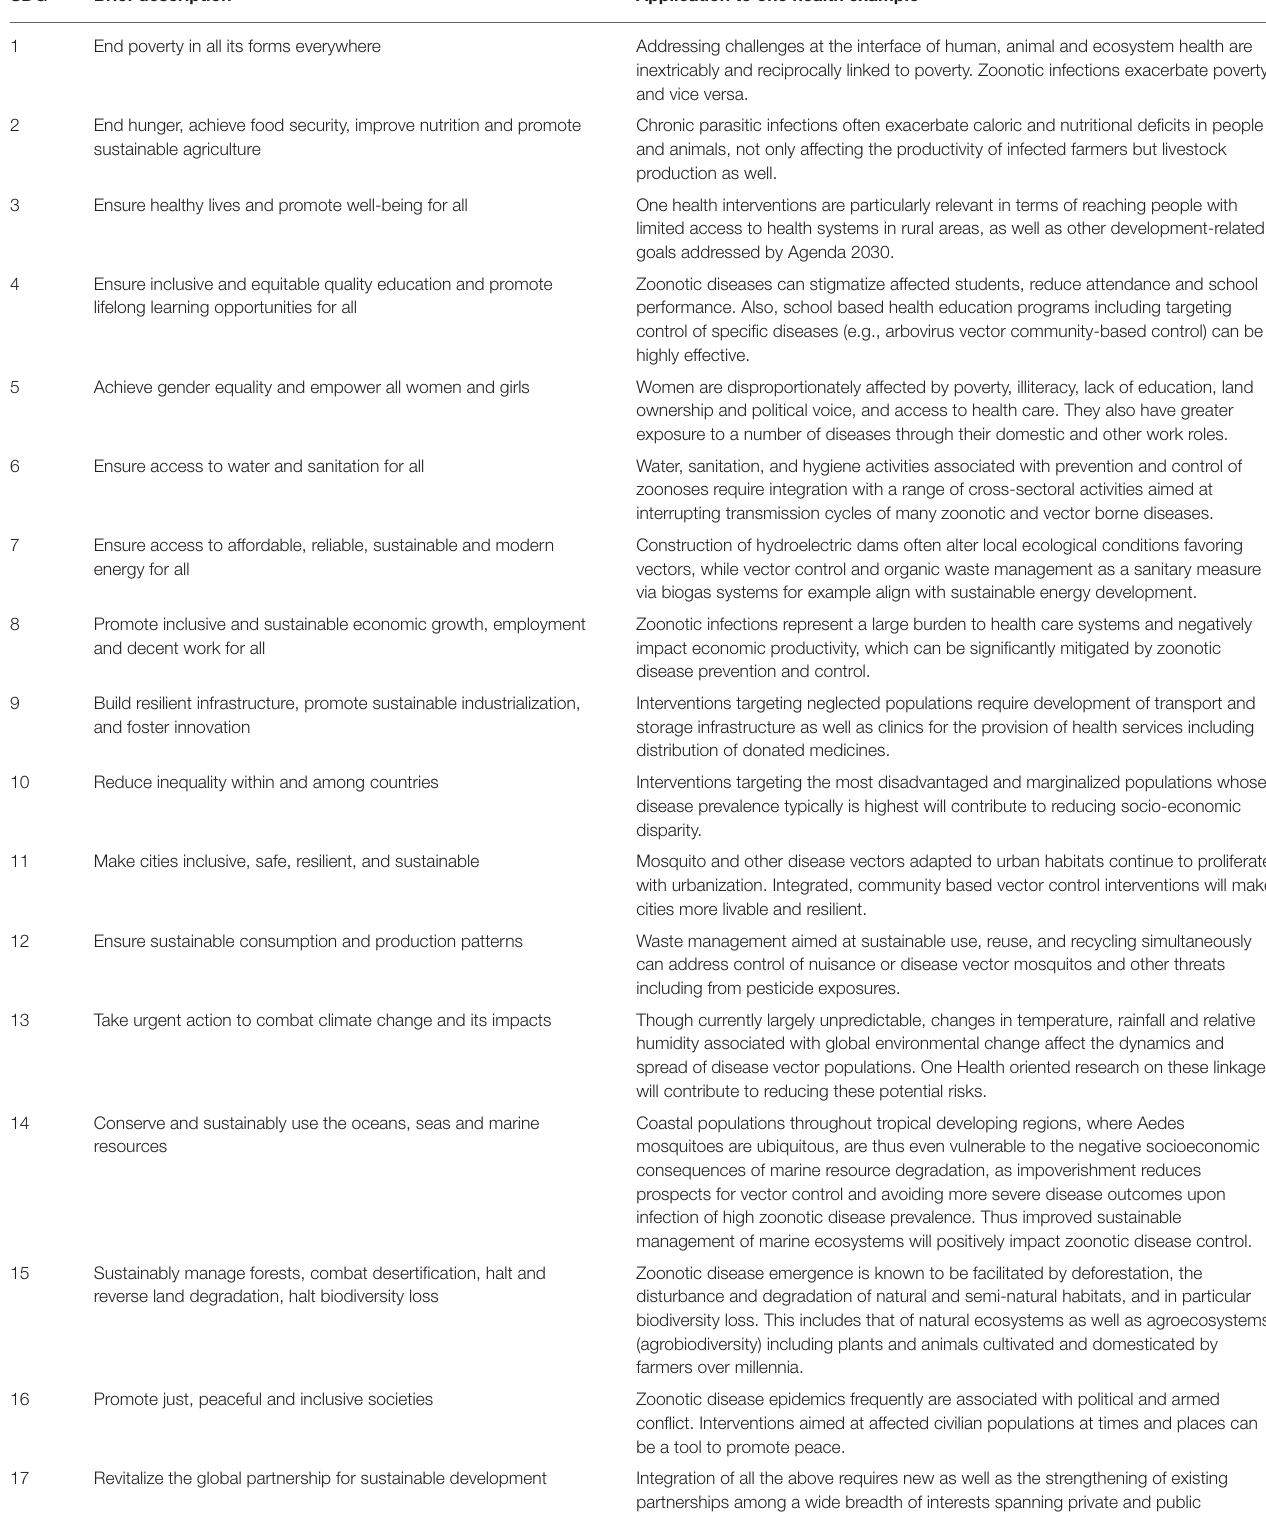
TABLE 2 | United Nations Sustainable Development Goals (SGDs) from a One Health Perspective as they relate to zoonotic and vectorborne diseases. SDG Brief description Application to one health